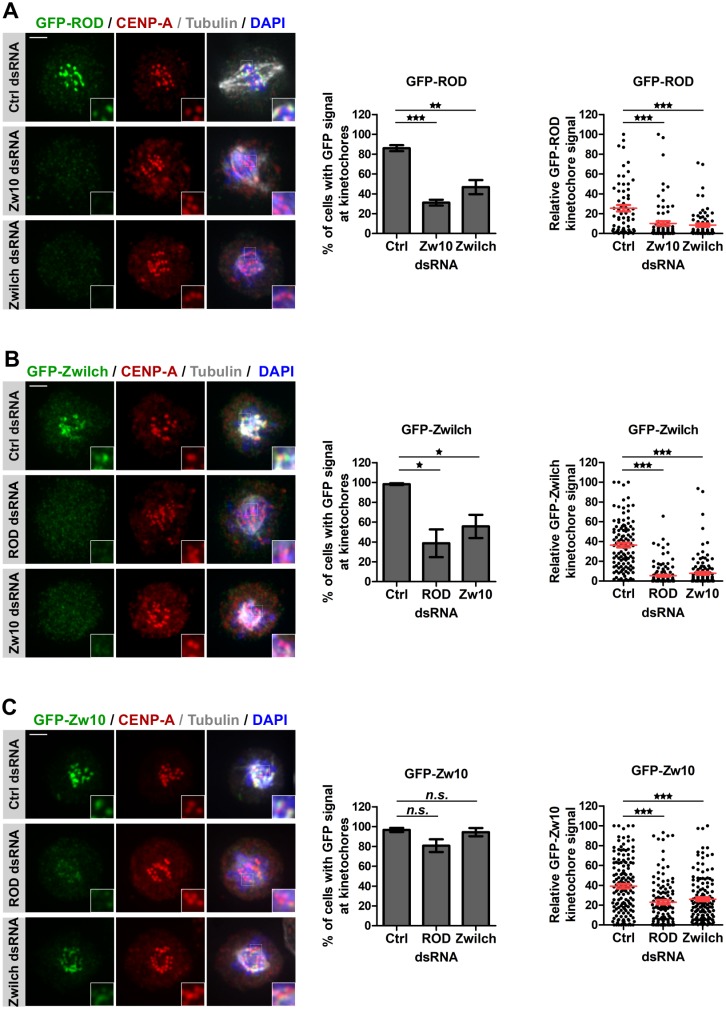
Zw10 is the most proximal RZZ component at kinetochores in Drosophila.A. Left panel Immunofluorescence of cells expressing GFP-ROD and mCherry-Tubulin after 96 h depletion of RZZ components stained with anti-GFP antibody (green) and anti-CENP-A (red), DNA (DAPI) is shown in blue. Middle panel. Prometaphase cells were counted for the presence or absence of GFP signal at kinetochores. Right panel. Quantification of total GFP-ROD kinetochore intensity per cell. GFP fluorescence intensity at kinetochores was measured for each cell and normalized within one experiment before pooling measurements from at least 3 experiments per condition. B. Similar experiments as in A were performed in GFP-Zwilch expressing cells. C. Similar experiments as in A were performed in GFP-Zw10 expressing cells. Mean +/- SEM, n>100 cells. Student’s t-test (n.s.: non-significant; *: p<0.05; **: p<0.01***: p<0.001). Scale bar: 2 μm.